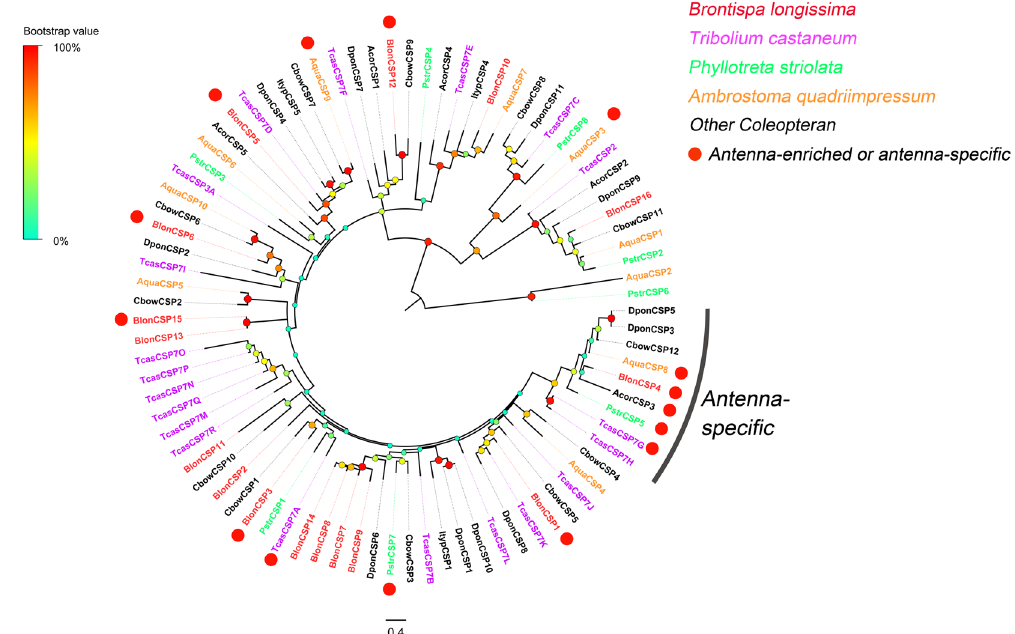
Figure 7. Phylogenetic tree of candidate CSPs from B. longissima (red labels), T. castaneum (purple labels), A. quadriimpressum (orange labels), P . striolata (green labels) and other coleopteran insects (black labels). Antennae-rich CSP in B. longissima are indicated as red dots. The tree was constructed using MEGA (v.6.0) with the WAG + G substitution model and NNI topology search, based on an amino acid alignment by MAFFT. Branch support (circles at the branch nodes) was estimated using an approximate likelihood ratio test based on the scale indicated at the top left. Bars indicate branch lengths in proportion to amino acid substitutions per site. CSP prefixes indicate the following: Acor, A . corpulenta ; Aqua, A . quadriimpressum ; Blon, B . longissima ; Cbow, C . bowringi ; Dpon, D . ponderosae ; Ityp, I . typographus ; Pstr, P . striolata ; Tcas, T . castaneum